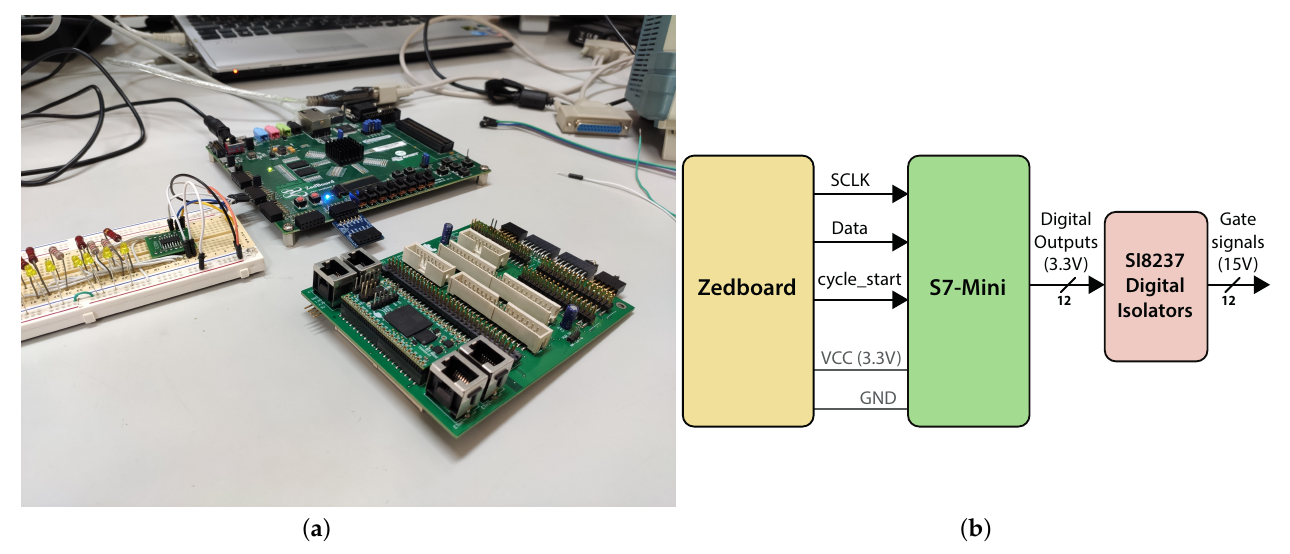
Figure 23. Zedboard and custom board for I/O management using an S7-Mini board. ( a ) Zedboard and custom secondary FPGA board. ( b ) Schematic connection representation.